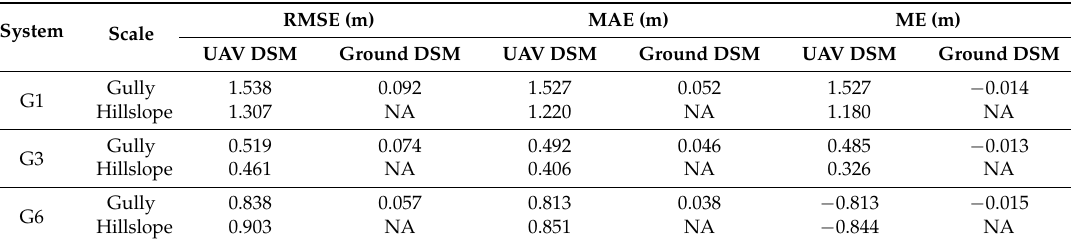
Table 4. Summary of elevation errors in the comparison of RTK validation points and UAV and ground DSMs (i.e., point-to-raster comparison).